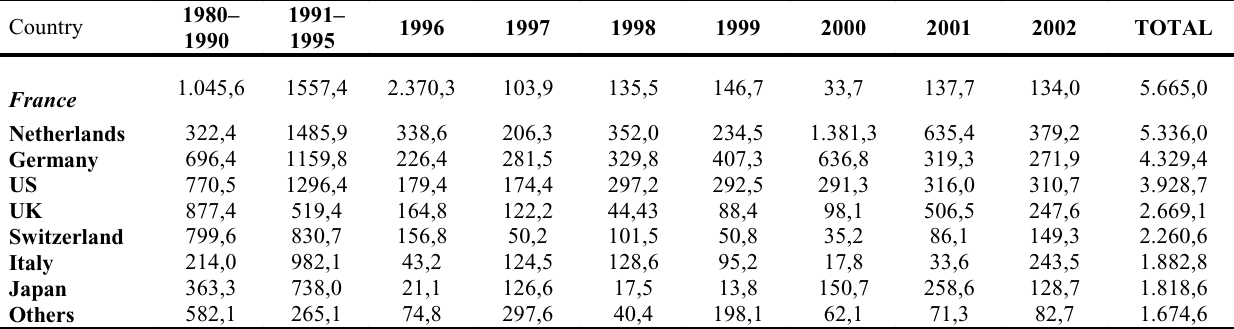
Table 4. Breakdown of Authorised FDI According to Home Countries in Turkey, million $